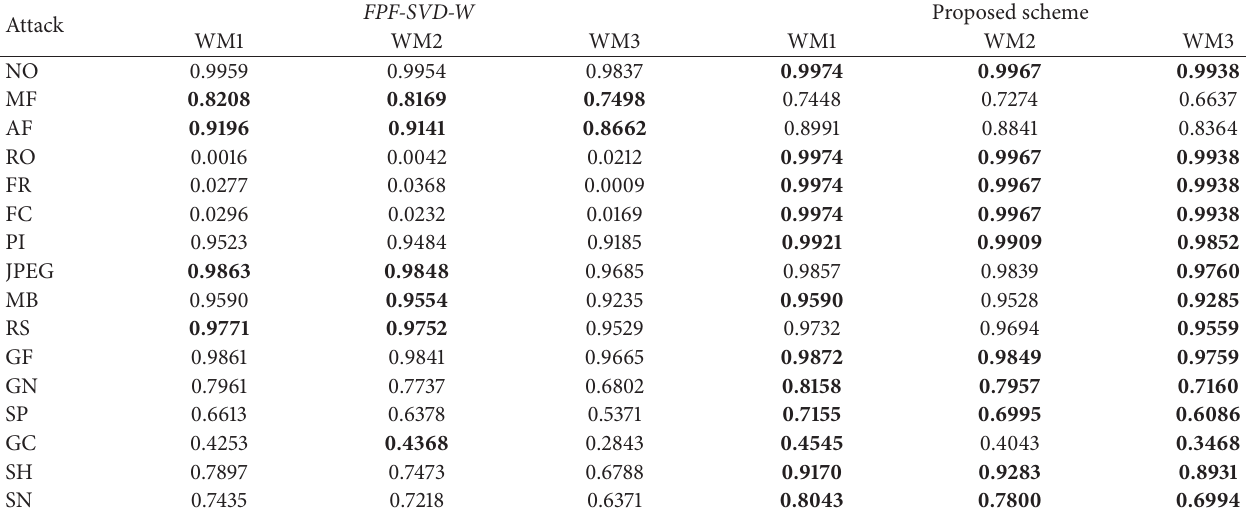
Table 5: The average of correlation values of the extracted watermarks under different attacks.